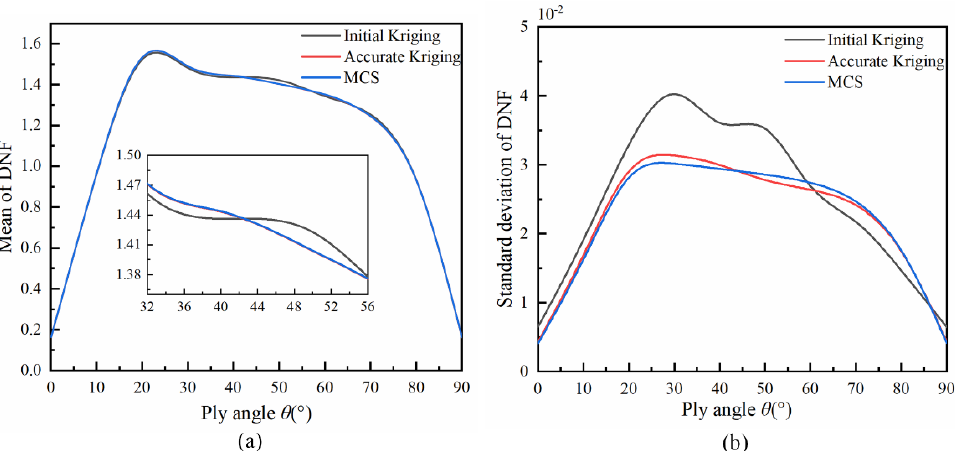
Figure 3. The mean and standard deviation of DNF for the three-layer laminated composite cylindrical shells with clamped–clamped boundary conditions. ( a ) mean, ( b ) standard deviation.